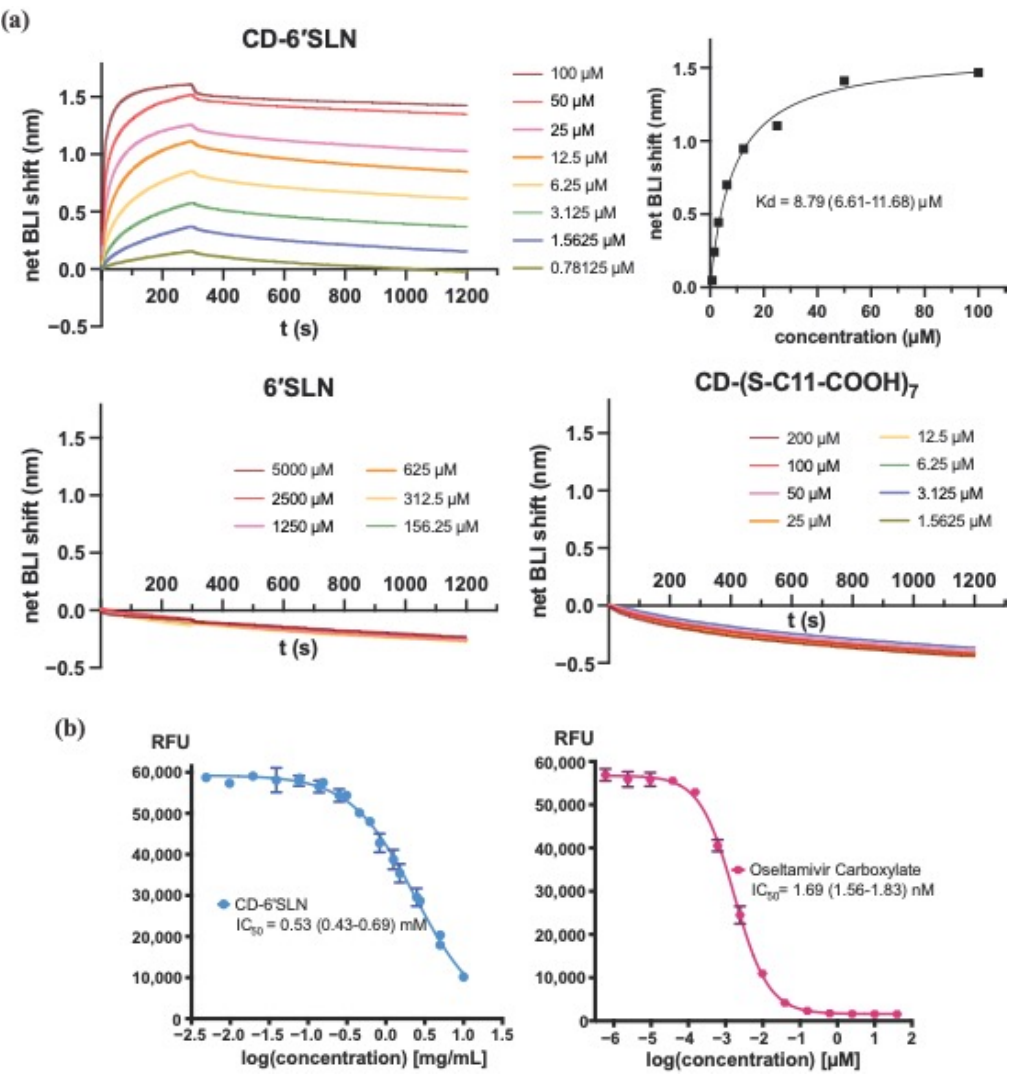
Figure 3. CD-6’SLN bind to H1N1 hemagglutinin instead of neuraminidase. ( a ) Binding of CD- Figure 3. CD-6 (cid:48) SLN bind to H1N1 hemagglutinin instead of neuraminidase. ( a ) Bind- 6’SLN, 6’SLN and CD-(S-C11-COOH) 7 to immobilized his-tagged hemagglutinin (H1N1, ing of CD-6 (cid:48) SLN, 6 (cid:48) SLN and CD-(S-C11-COOH) 7 to immobilized his-tagged hemagglu- A/California/04/2009). ( b ) Dose-response inhibition of neuraminidase (H1N1, A/California/04/2009) tinin (H1N1, A/California/04/2009). ( b ) Dose-response inhibition of neuraminidase catalytic activity by CD-6’SLN and oseltamivir carboxylate.